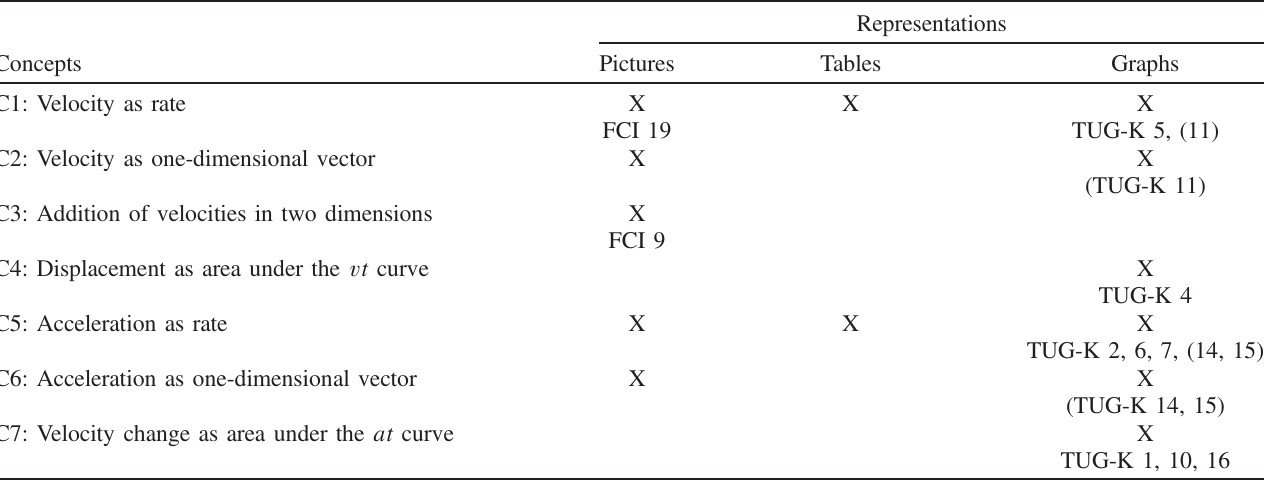
TABLE I. The relation of the KCT between concepts and representations (denoted by “ X ” ) and the numbers of the items we used and adapted from the FCI and the TUG-K. Three items of the TUG-K (11, 14, 15) can be assigned to two concepts each.